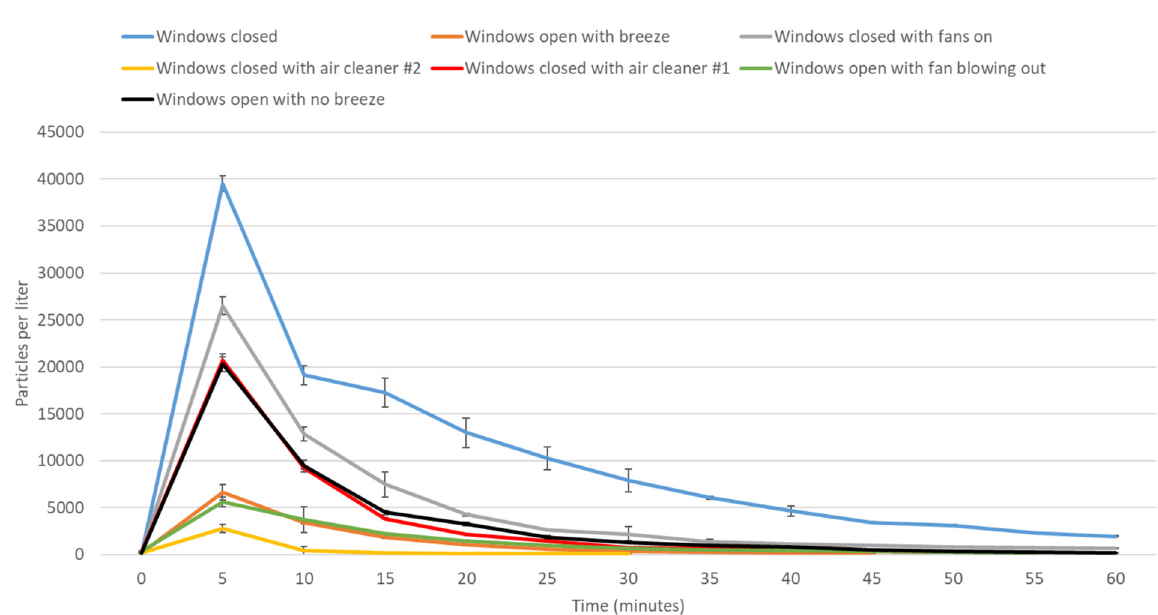
Figure 3. Clearance of carbon dioxide generated by cooking with a gas stove. Clearance of carbon dioxide generated by cooking with a gas stove in a kitchen (volume, 43.5 m 3 ) with windows closed versus with several different interventions to improve ventilation. Fans included an overhead ceiling fan, stove fan without external ventilation, and the central air conditioning fan on in continuous mode. Average results for 3 experiments are shown. Error bars represent standard deviation.